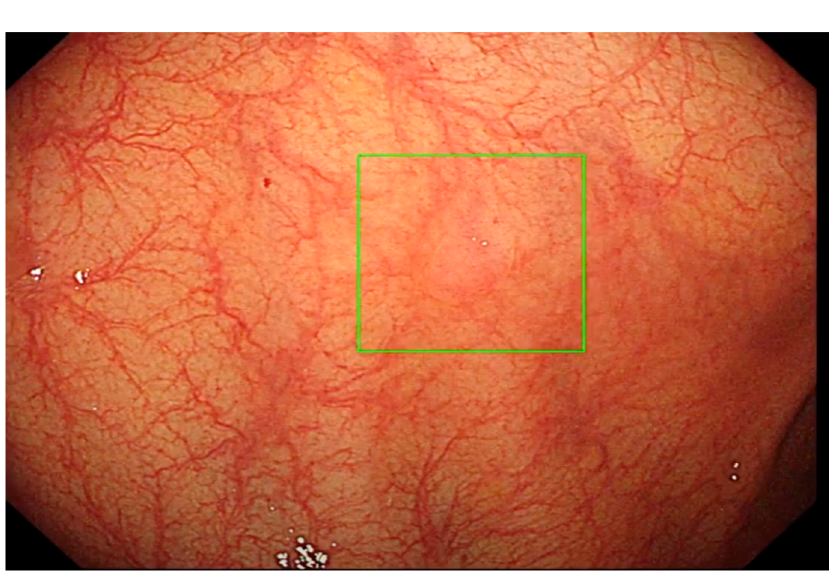
Figure 5. Flat polyp detected by CADe AI.